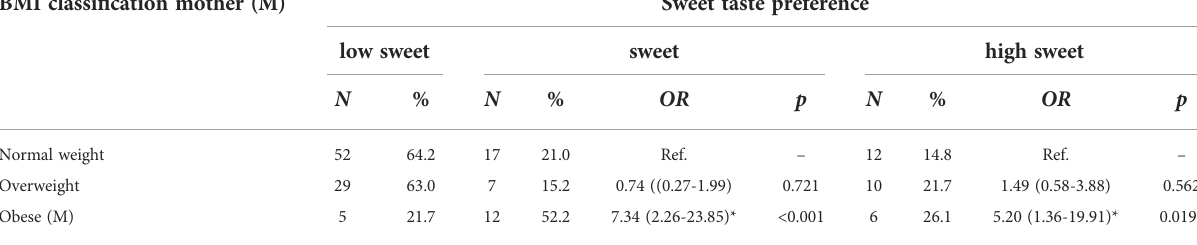
TABLE 5 Association between mother ’ s sweet taste preferences and their body mass index